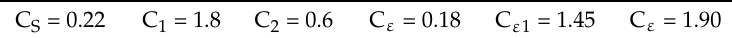
Table 4. Constants of the Reynolds stress turbulence